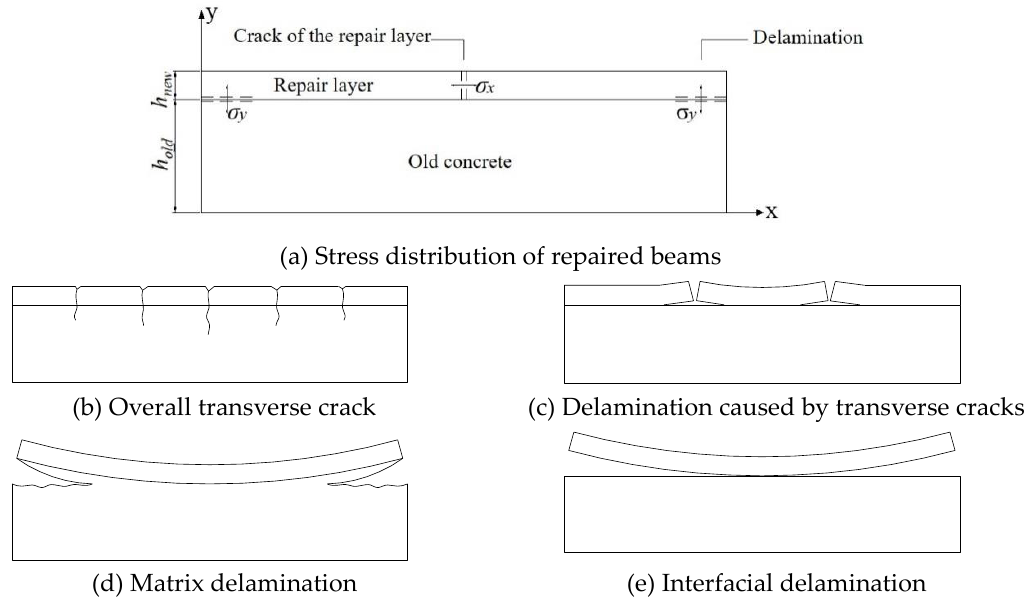
横向裂缝 Figure 10. Restrained shrinkage stress and failure mode of SHCC-repaired beams. Figure 10. Restrained shrinkage stress and failure mode of SHCC-repaired